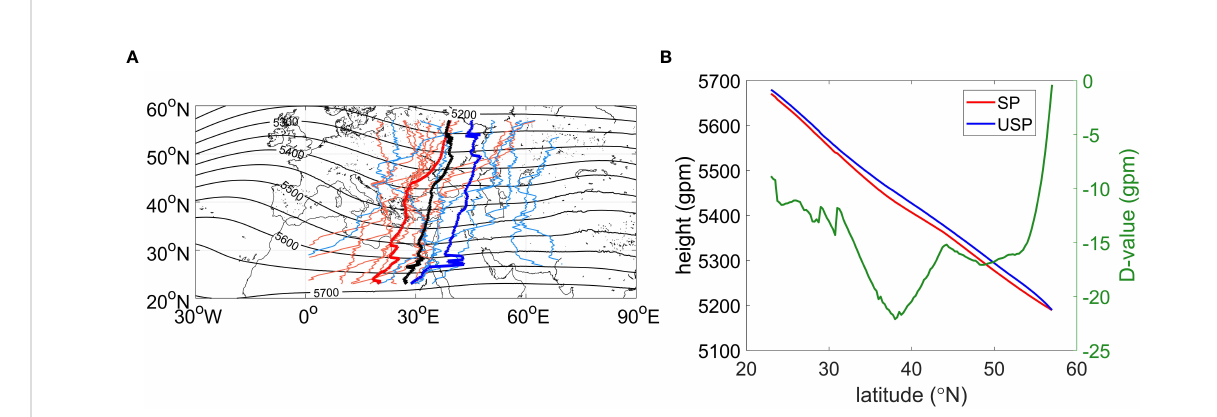
FIGURE 2 (A) The winter year-to-year MedT axis lines for KE SP (light red lines) and USP (light blue lines) traced from the ERA5 500-hPa geopotential height and superposed with the winter climatology of 500-hPa geopotential height (contours with an interval of 50 gpm). Thick red line and blue line show the composite MedT axis lines for KE SP and USP, respectively, and thick black line is the climatological mean MedT axis. (B) Composite 500- hPa geopotential height along the MedT axis lines for KE SP (red line, left y-axis) and USP (blue line, left y-axis) and its difference between the SP and USP (green line, right y-axis). MedT, Mediterranean trough; KE, Kuroshio Extension; SP, stable period; USP, unstable